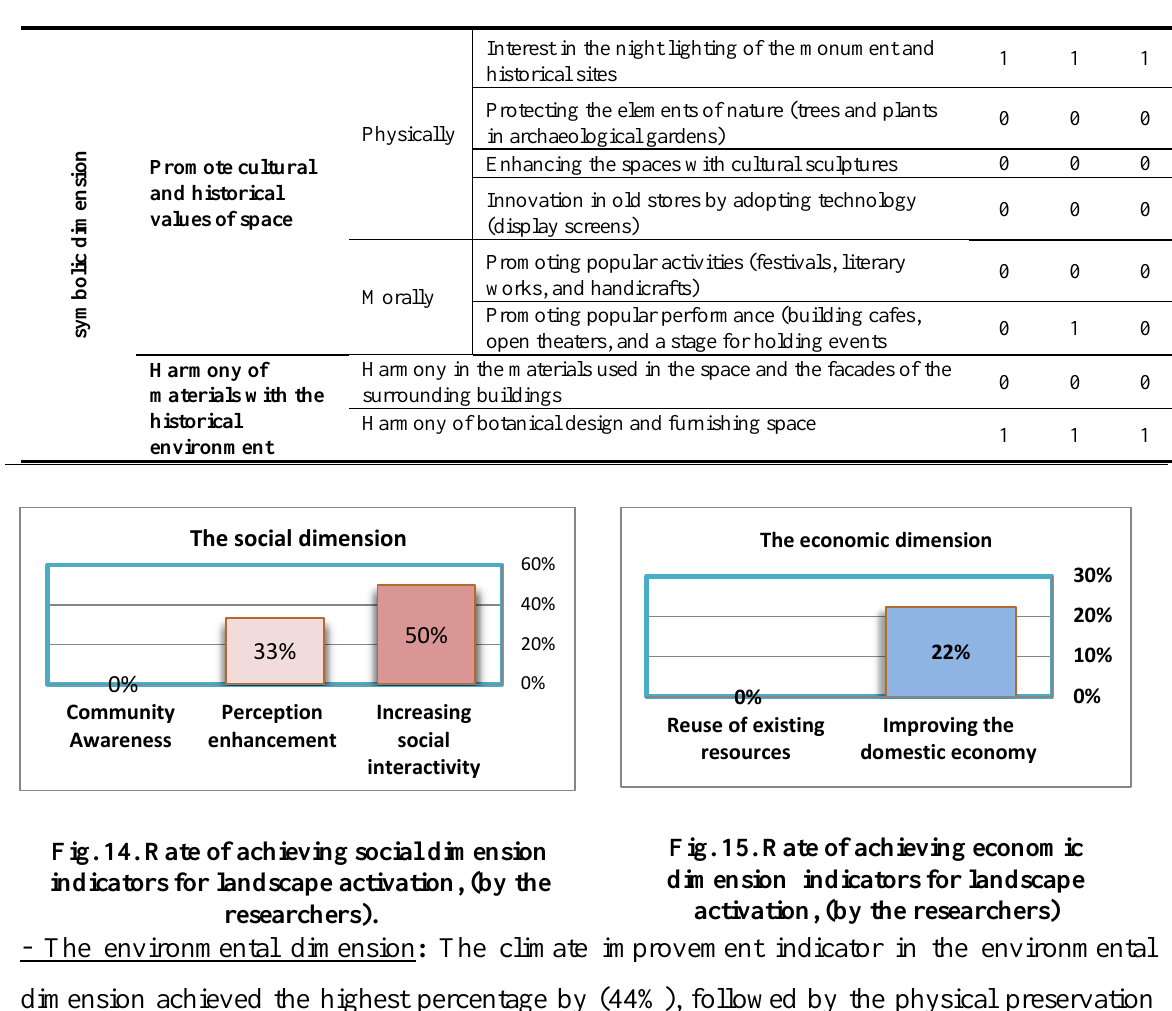
Fig. 15. Rate of achieving economic dimension indicators for landscape activation, (by the researchers)